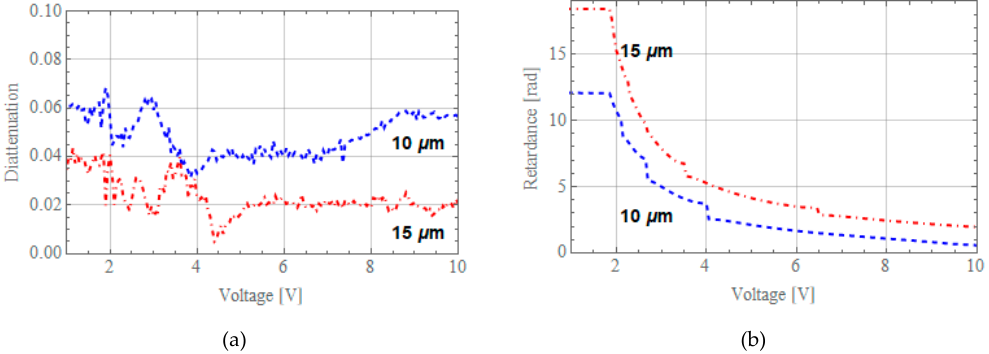
Figure 6. Calculated: ( a ) diattenuation and ( b ) retardance of tested PVAN cells with thicknesses of 10 μ m (blue dotted line) and 15 μ m (dot-dashed line).